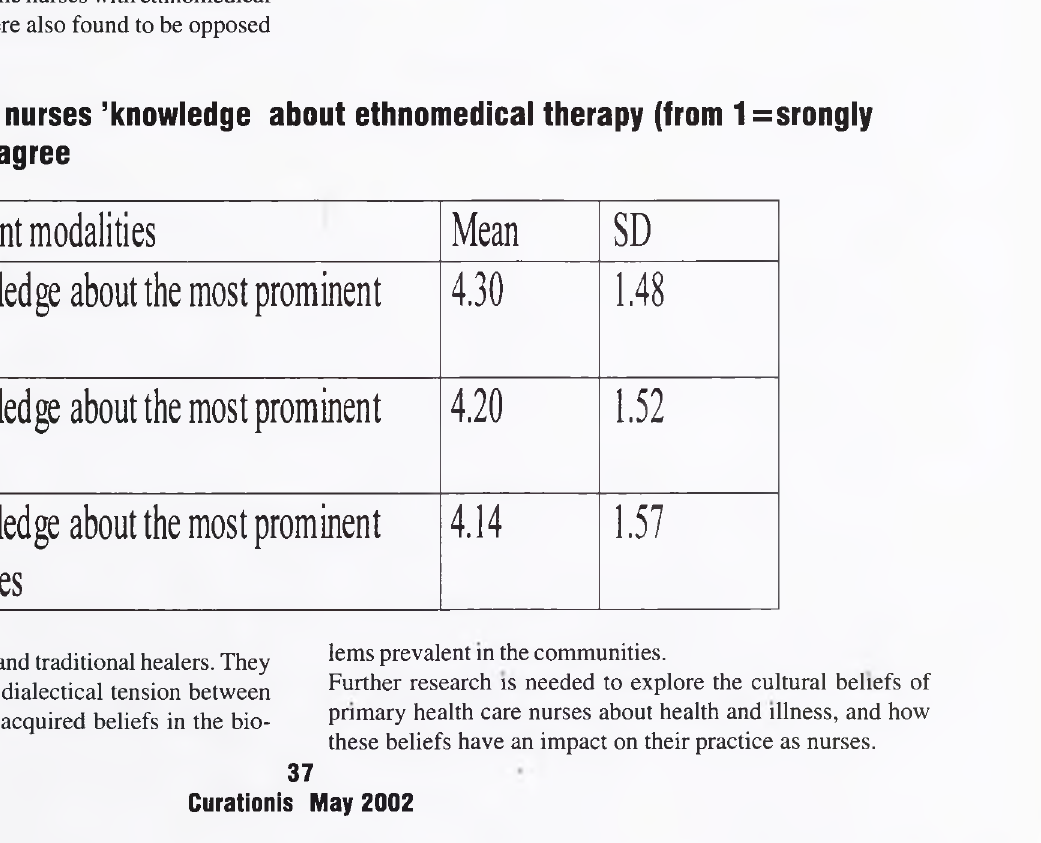
Table 8: Mean ratings of nurses ’knowledge about ethnomedical therapy (from 1=srongly disagree to 6 = strongly